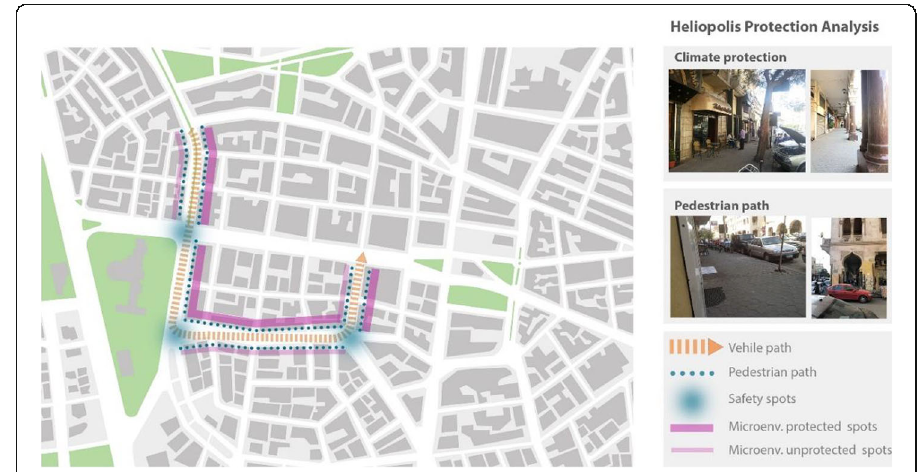
Fig. 4 Heliopolis map, Analysis of Protection aspect in Roxy and Korba Street (Author)